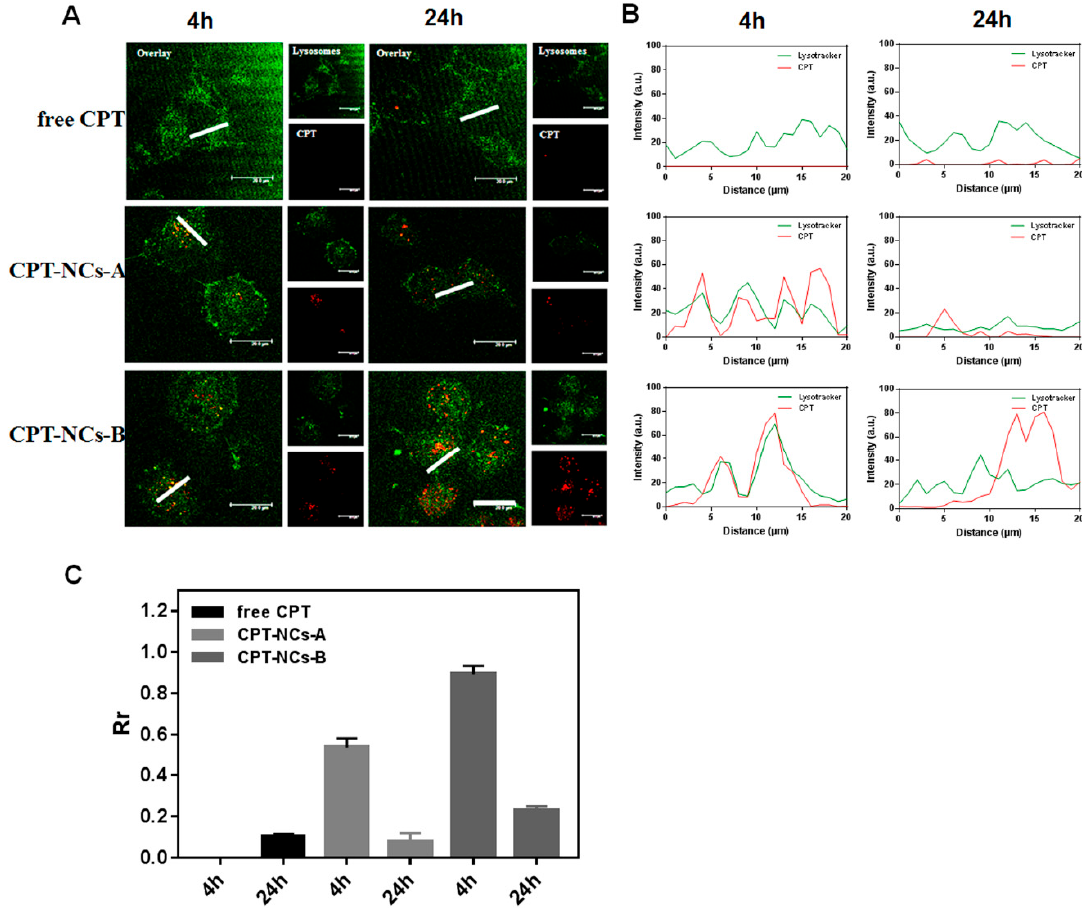
Figure 4. ( A ) confocal laser scanning microscope (CLSM) of SCC-15 cells after treatment with free CPT, CPT-NCs-A, and CPT-NCs-B for 4 h. Scale bar = 100 μ m; ( B ) The quantitative fluorescence intensity of squamous cell carcinoma (SCC-15) cells after treatment with free CPT, CPT-NCs-A, and CPT-NCs-B for 4 h by Image-Pro Plus.